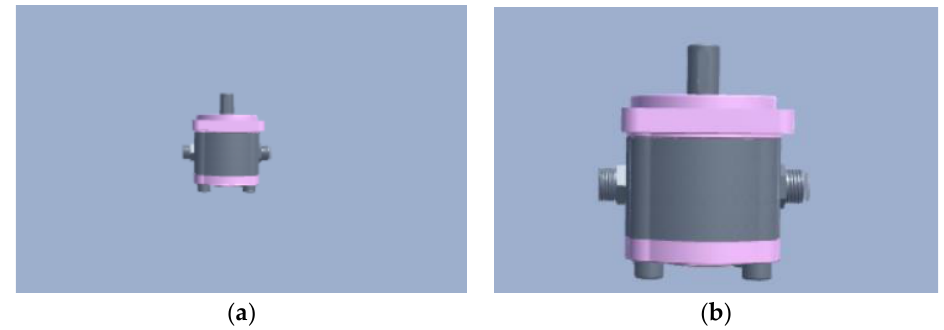
Figure 8. Scaling of the external gear pump: ( a ) Before enlargement. ( b ) After enlargement.